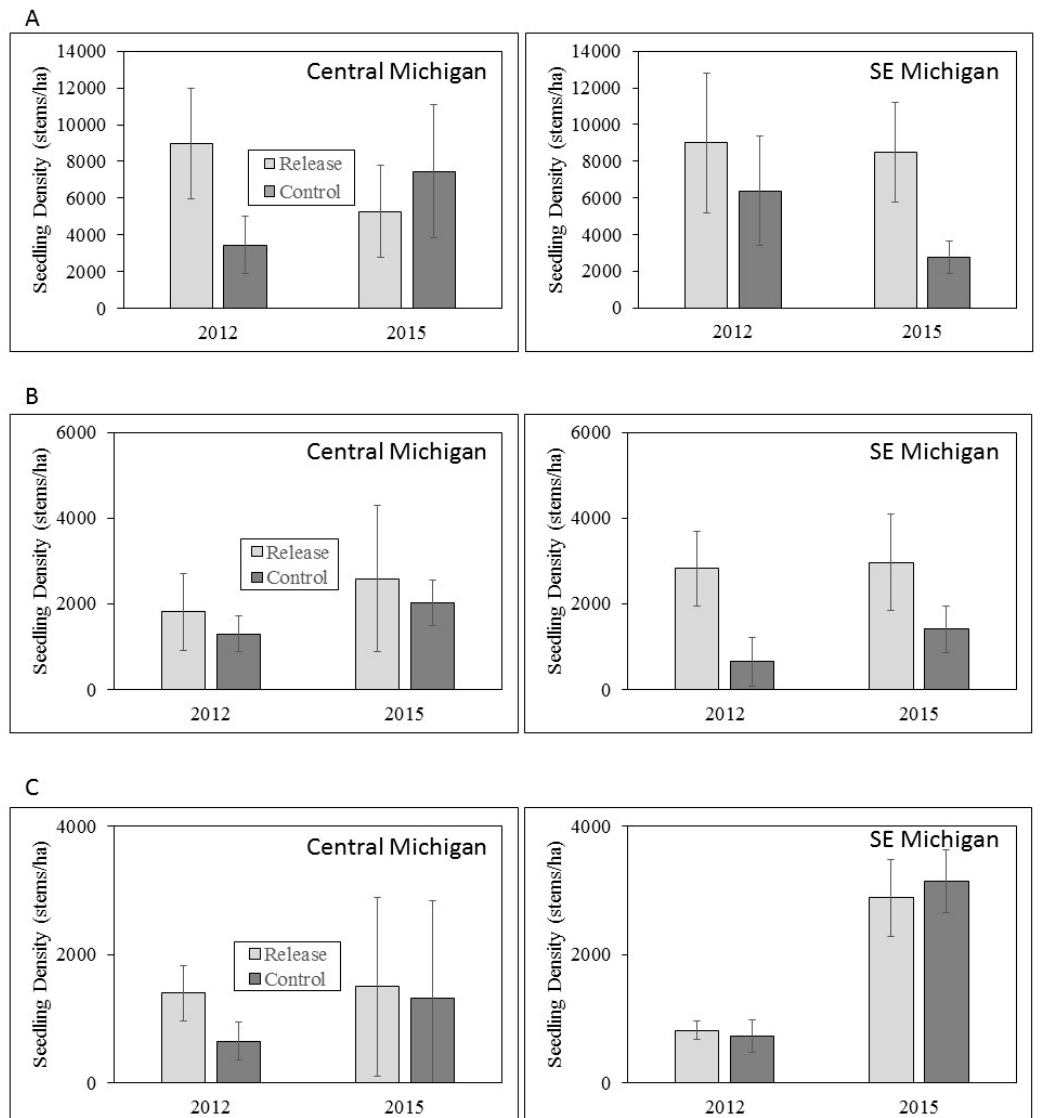
Figure 4. Mean seedling densities for ( A ) seedlings <0.5 m tall; ( B ) seedlings 0.5 – 1.0 m tall; and ( C ) >1 m tall in central and southeastern Michigan in 2012 and 2015. Error bars represent ± 1 SE. Note differences in scale of Y axis among seedling height classes.